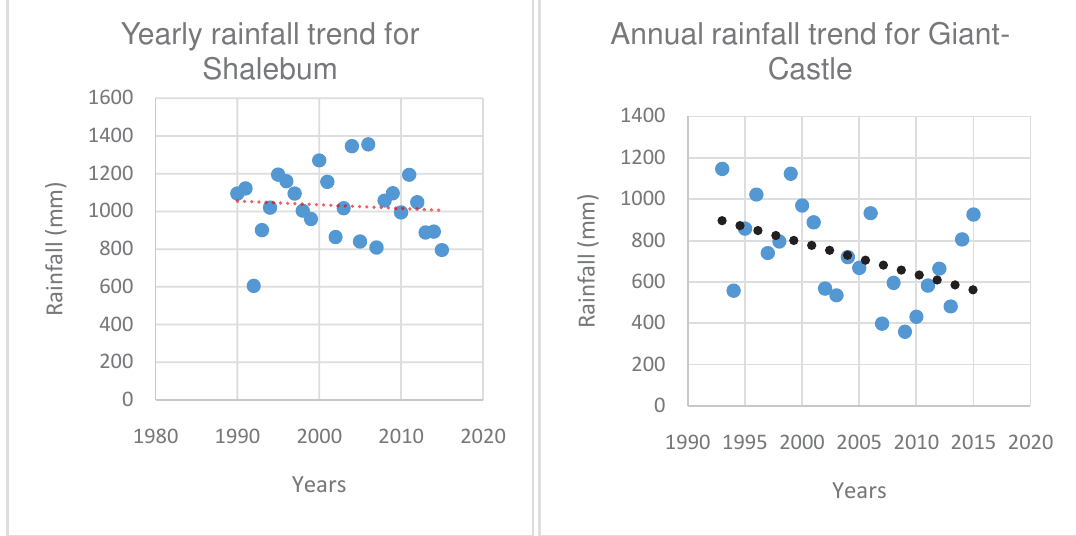
Fig. 8. The sharp decline in annual rainfall for Mkomazi